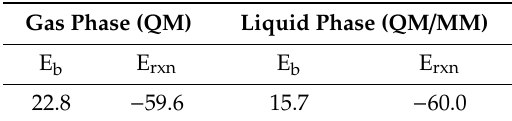
Table 2. Comparison of potential energy barrier (Eb) and reaction energy (Erxn) in gas phase and liquid. All values are in kcal · mol − 1 .